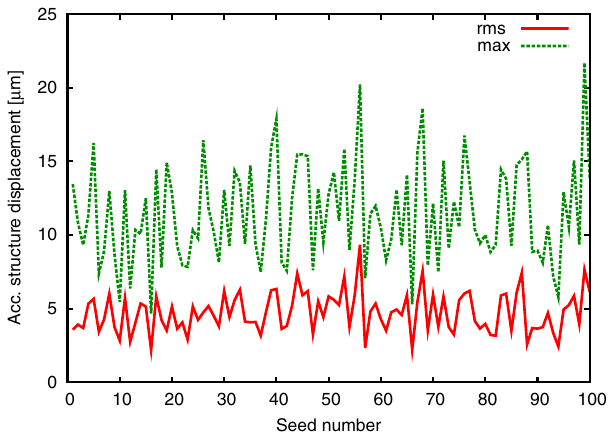
FIG. 19. Root-mean-square and maximum displacements of 662 accelerating structures controlled by eight knobs after correction of each of 100 seeds.